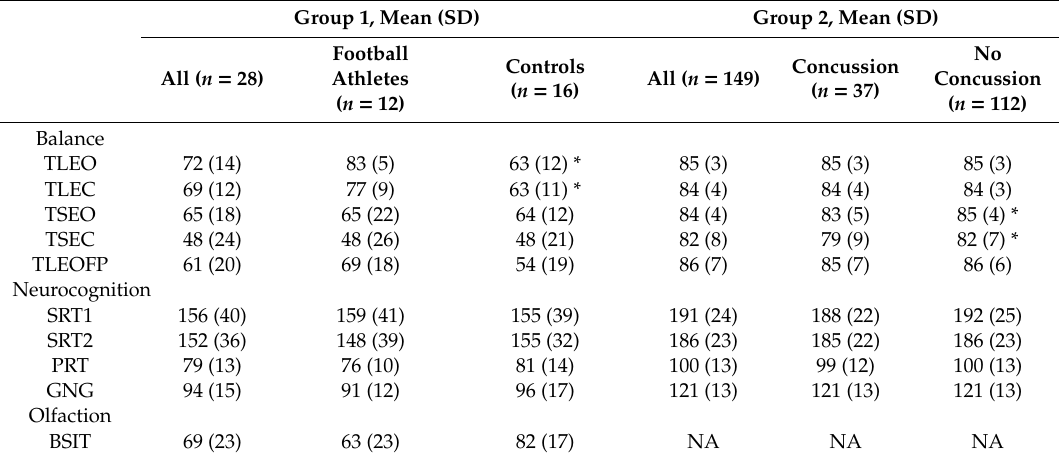
Table 2. Functional measures of balance, neurocognition, and